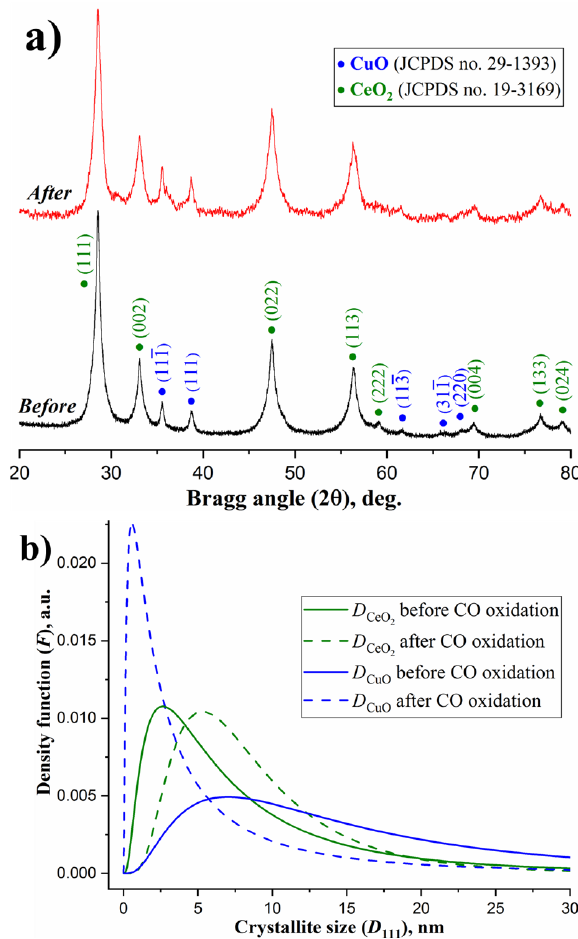
Figure 9: XRD pattern of CuO/CeO 2 -urea catalyst derived from the SCS method before and after CO oxidation (a); crystallite size distribution of CuO and CeO 2 nanoparticles obtained before and after CO oxidation (b). Table 2: Characterization of CuO/CeO 2 -urea catalyst after carrying out the oxidation of CO with five cycles CuO/CeO 2 -urea catalyst Before CO oxidation After CO